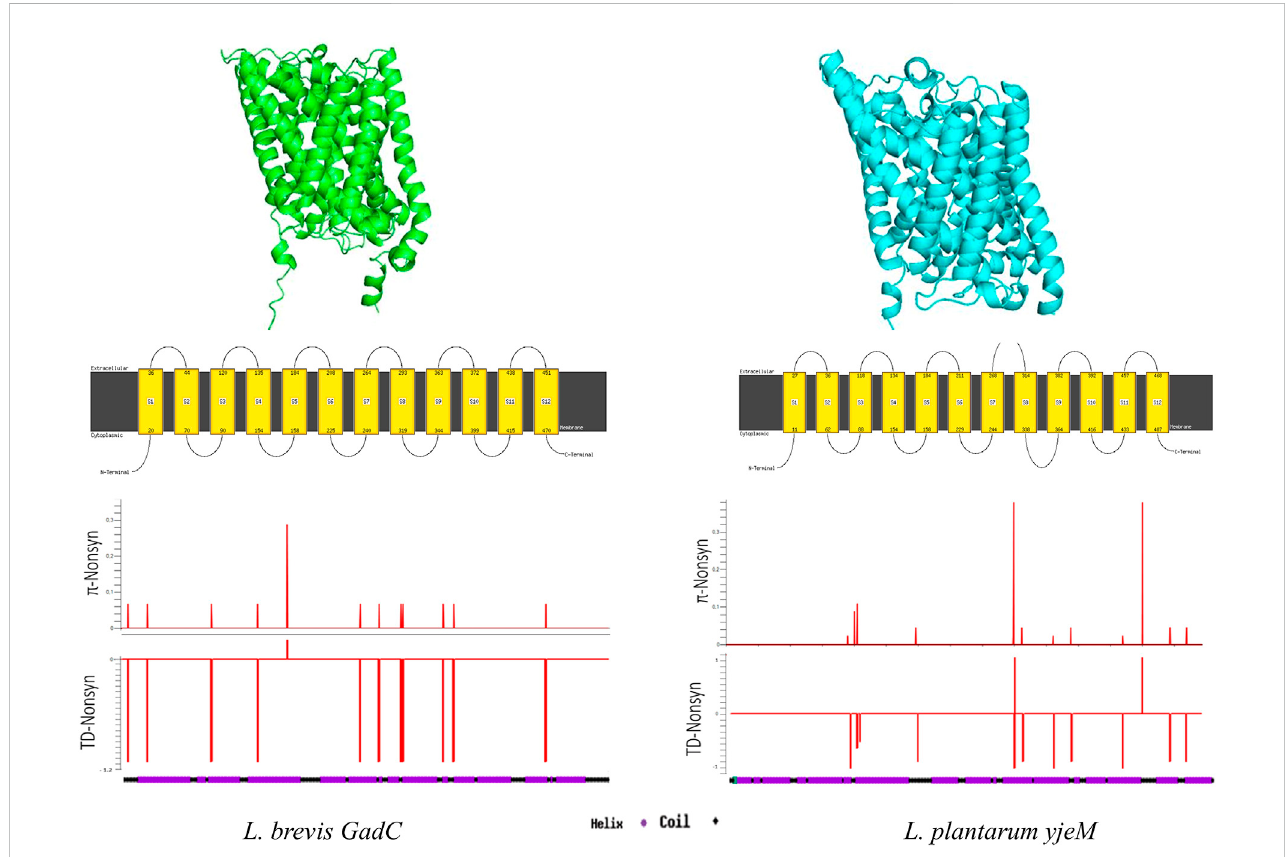
FIGURE 3 Secondary and 3D structure predictions for GadC, and YjeM proteins. Sliding-window analyses show non-synonymous nucleotide diversity ( π ) and Tajima ’ s D test results throughout the genes.